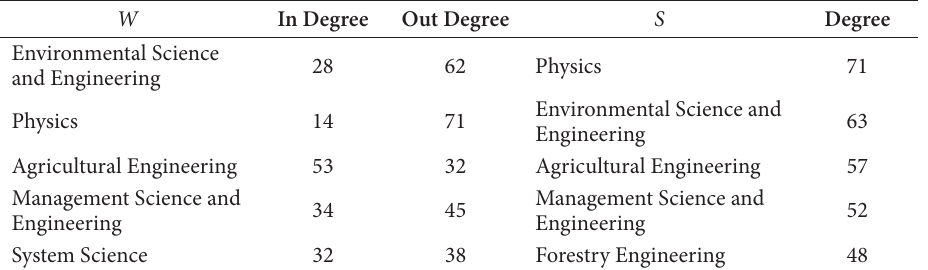
Table 1. Some of the largest nodes in networks W and S W